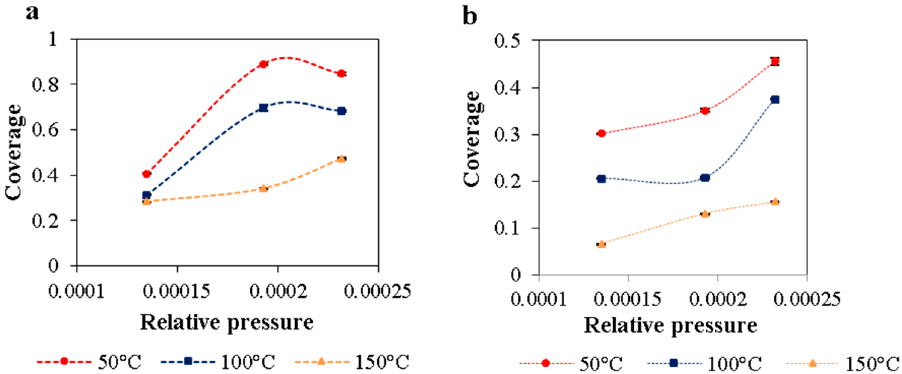
Figure 11. Ammonia Coverage over Ni surface ( a ) and over Fe surface ( b ).